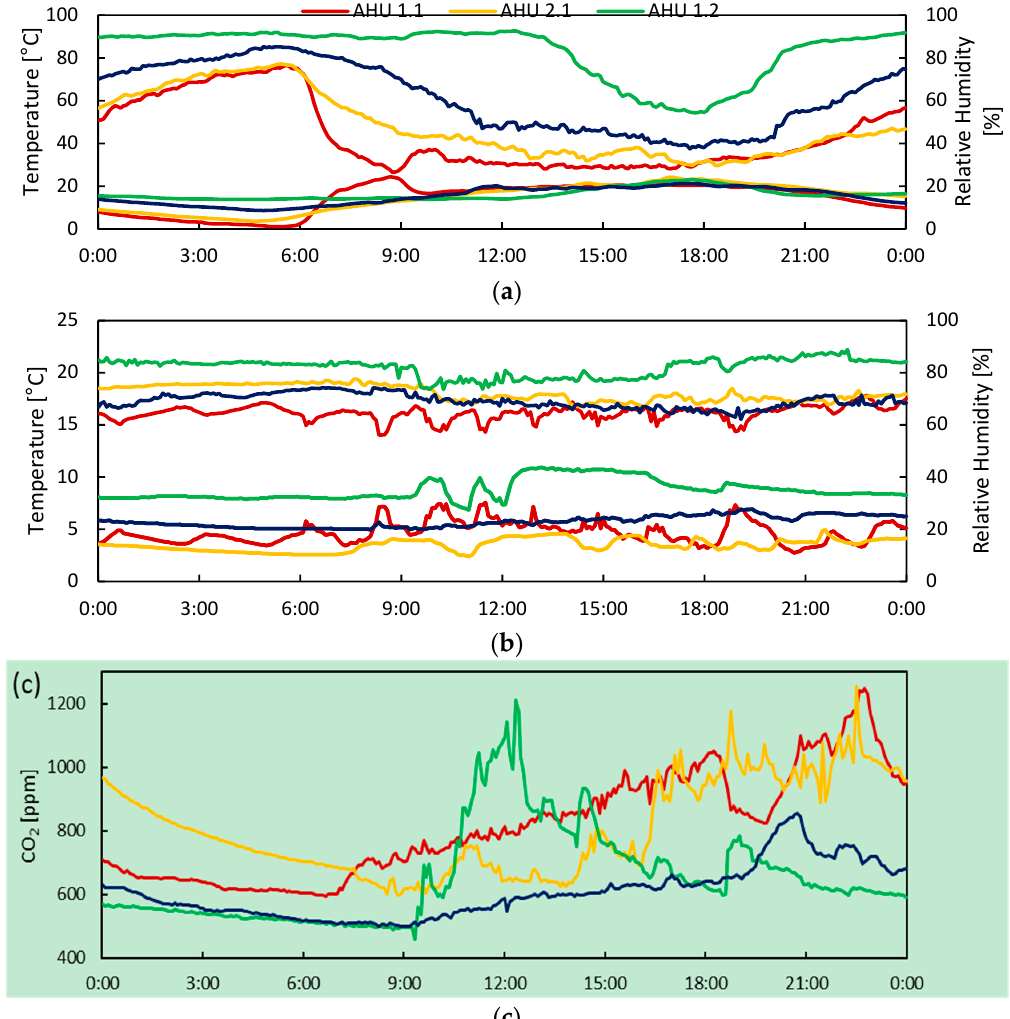
Figure 13. Indoor and outdoor air temperature, relative humidity and CO 2 measurements ( a ) Outside air temperature and relative humidity measurements; ( b ) Indoor air temperature and relative humidity measurements; ( c ) Indoor air CO 2